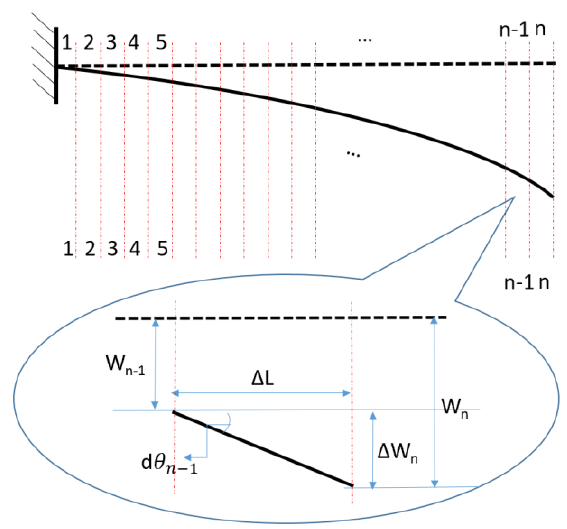
Figure 10. Element map for strain-deflection equation method.